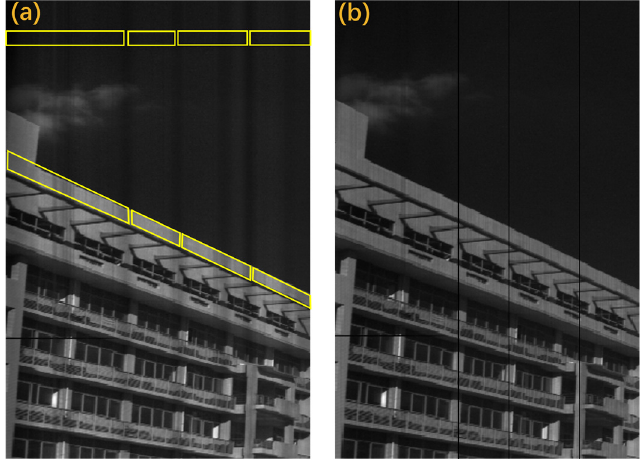
Figure 10. NUC using N-MIR data only. ( a ) MM-corrected results (broken yellow boxes mean that a complete row of uniform regions could not be obtained); ( b ) results of original N-MIR data correction using both MM + uniform region methods show strip noise with no data.